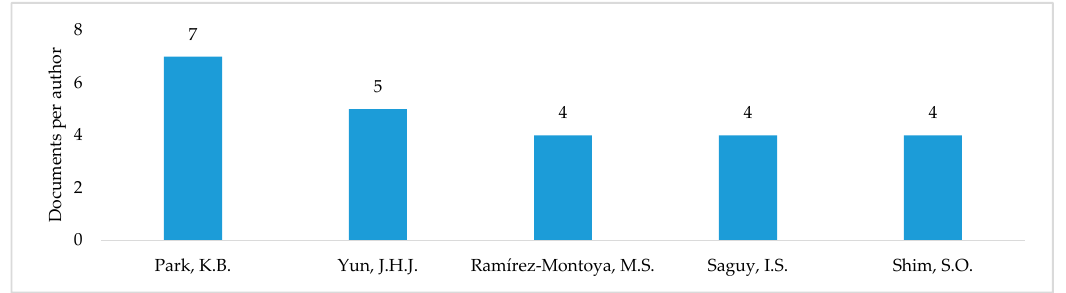
Figure 9. Leading authors on sustainability and open innovation.